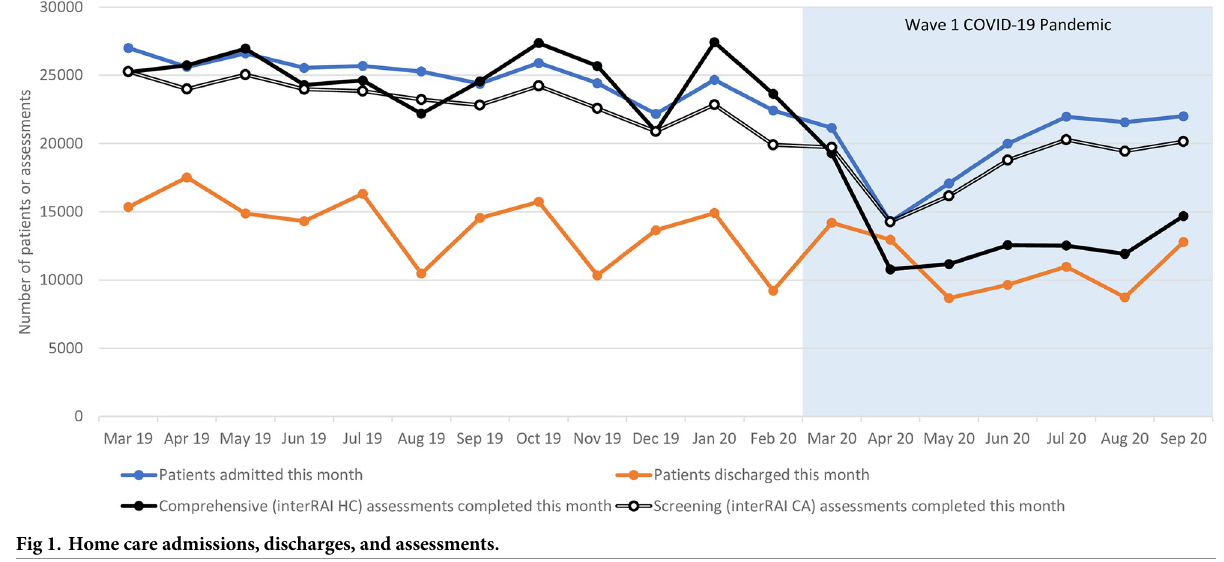
Fig 1. Home care admissions, discharges, and assessments.